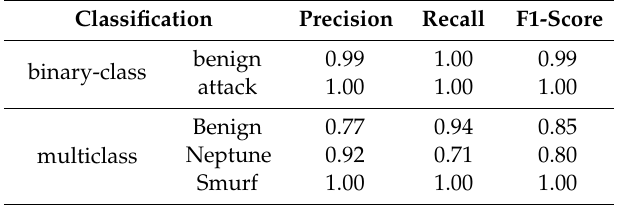
Table 11. Accuracy of the RNN model in binary and multiple classification in case of KDD.